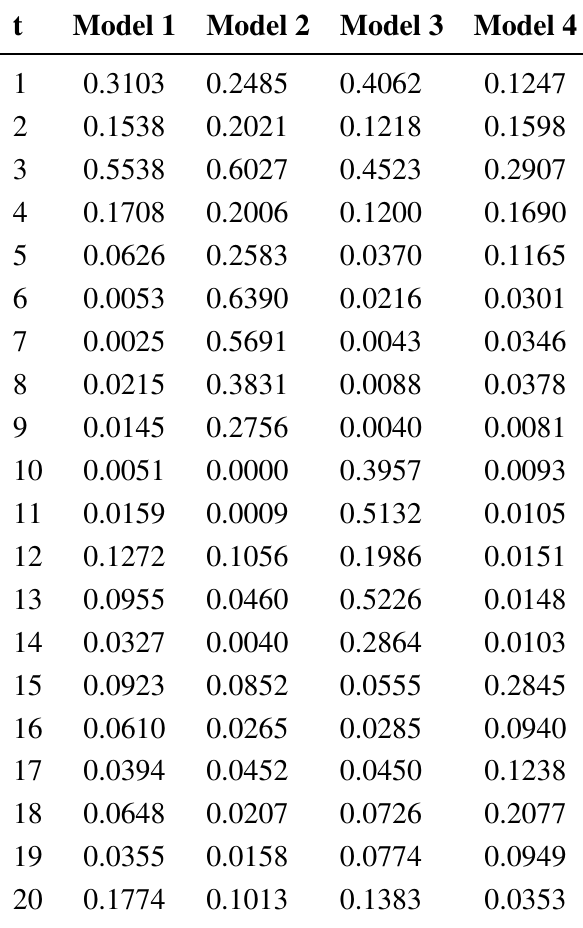
Table 2. Likelihood of dead reckoning for four